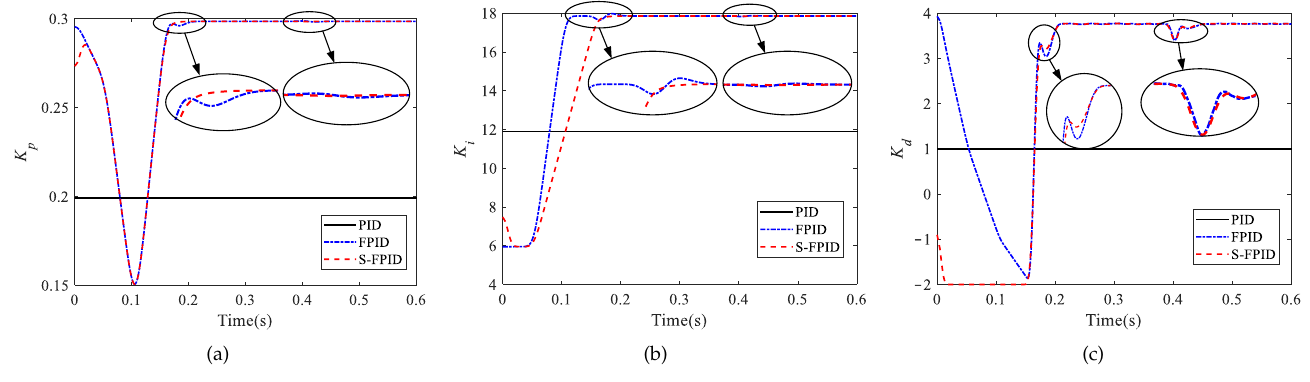
Figure 10. The tuning process of parameters: ( a ) K p , ( b ) K i , ( c ) K d